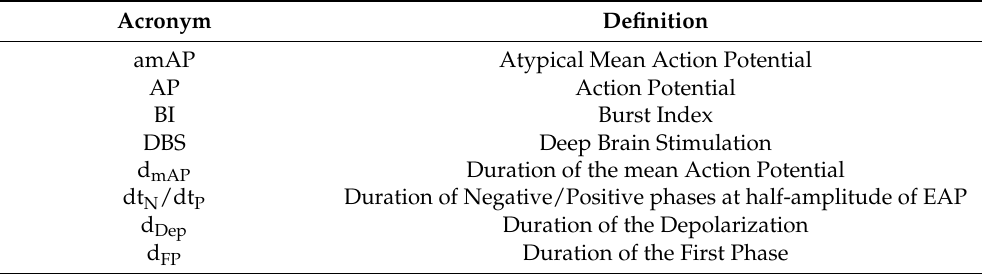
Table A1. Acronyms used along the